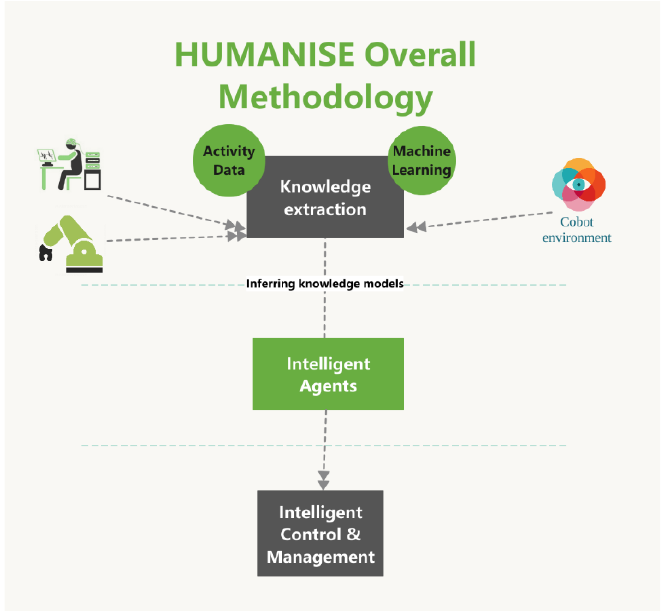
Figure 4. Diagram of the overall methodology of HUMANISE.